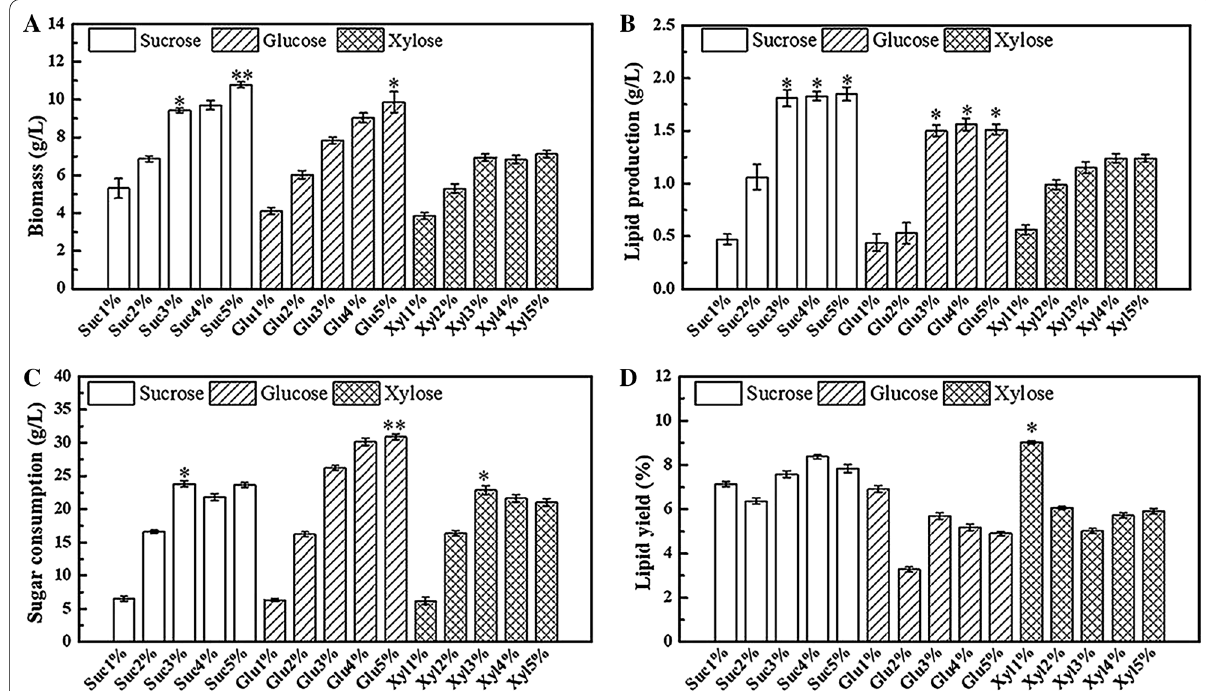
Fig. 1 Effects of different mass fractions of carbon sources on yeast. A Impact on biomass, B impact on lipid production, C impact on sugar consumption, D impact on lipid yield. The experimental data is measured at the 96th h of culture. Data are presented as the average of three independent experiments. Error bars represent means standard deviation. Significant differences were calculated using the t test (**p < 0.01, ± *p <